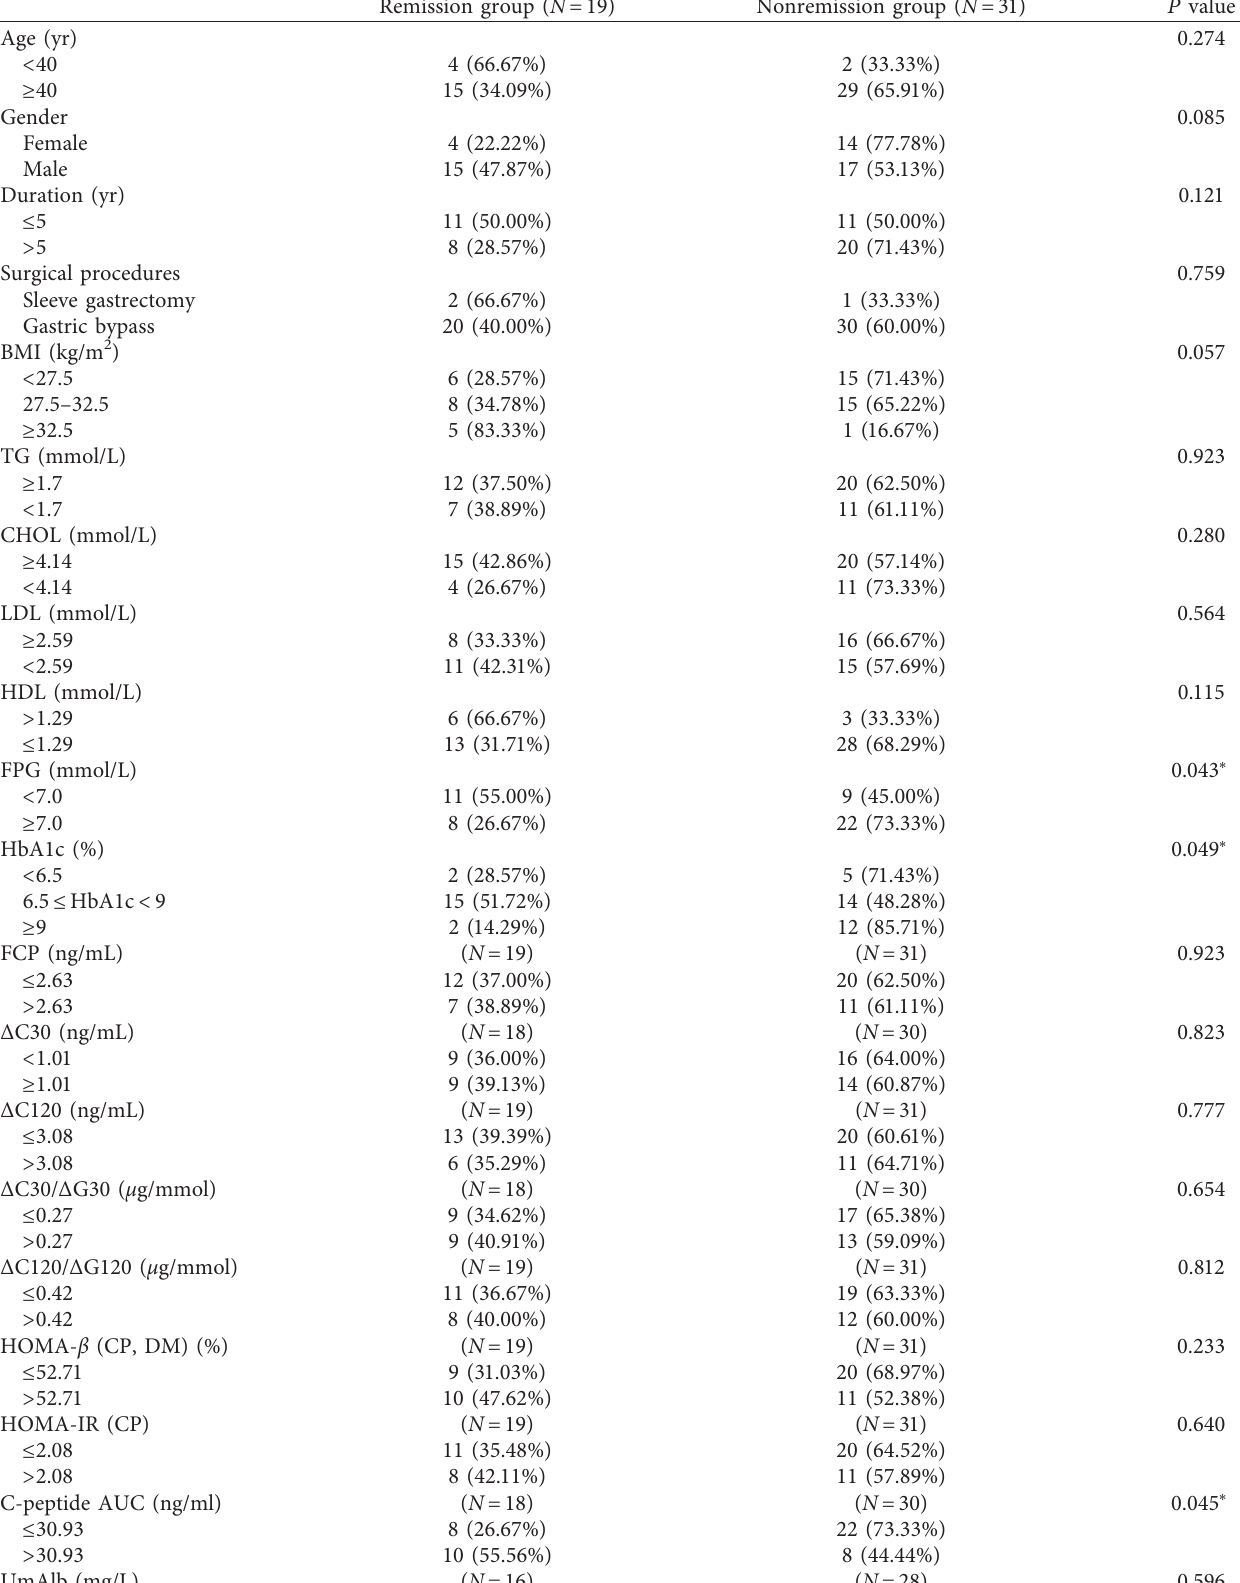
Table 4: Univariate analysis of prolonged remission